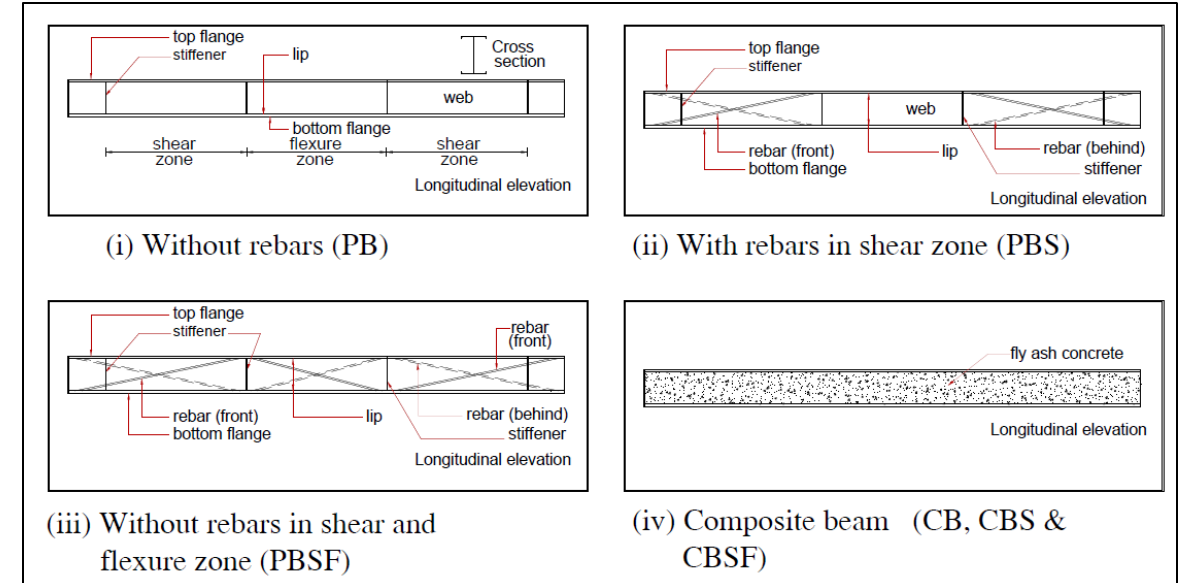
Figure 1. Fabrication of CFS beams with rebars and concrete-encased webs.